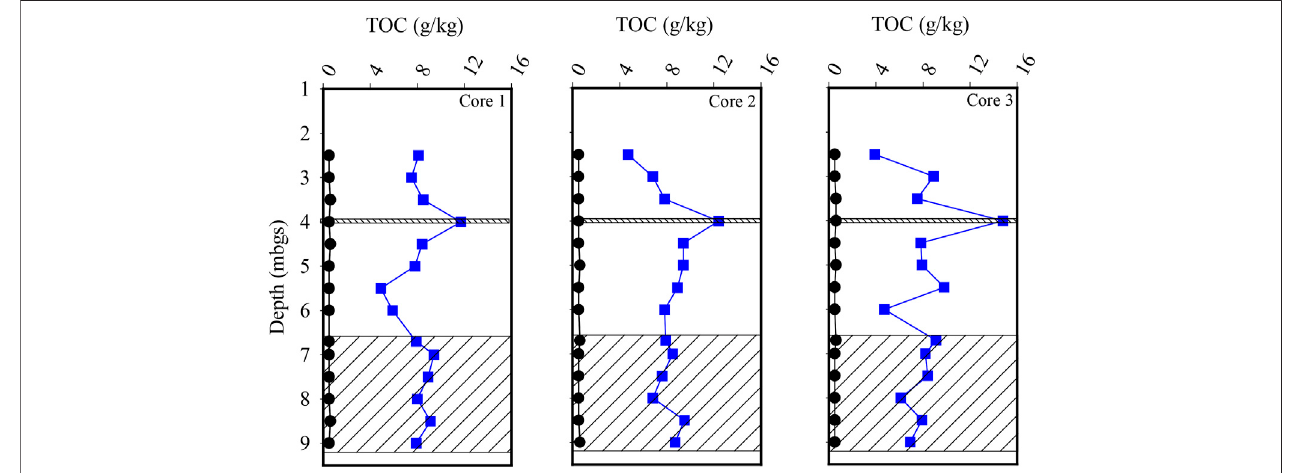
FIGURE 3 | Vertical pro fi les of total organic carbon within the silty sand and sand (hatched) aquifers. The black circles represent pre-injection results, and the blue squares represent post-injection results.